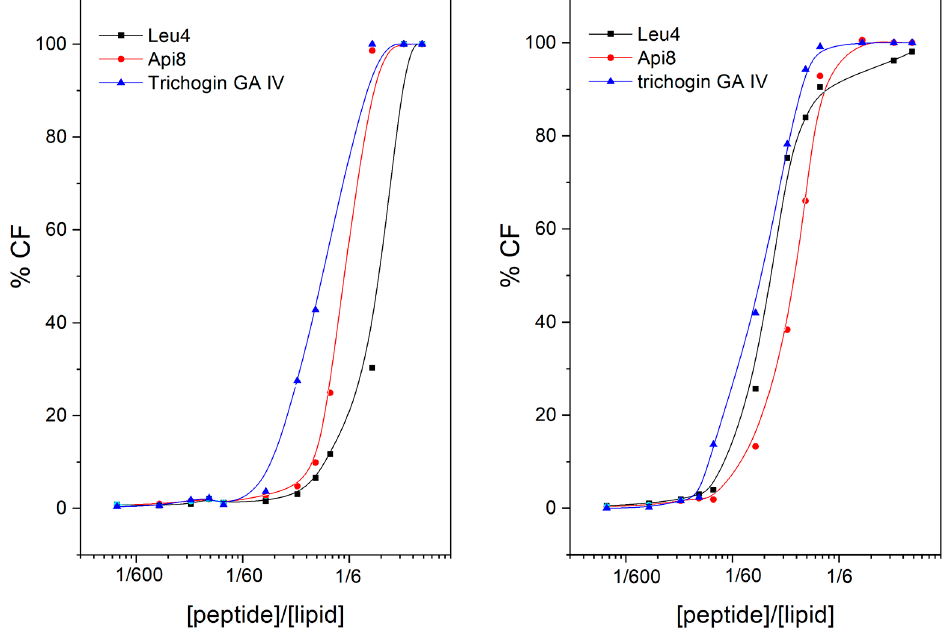
Figure 3. CF leakage from SUVs ( left , PC/Ch 7:3; right , PE/PG 7:3. Lipid concentration, 60 µ M) induced by increasing peptide